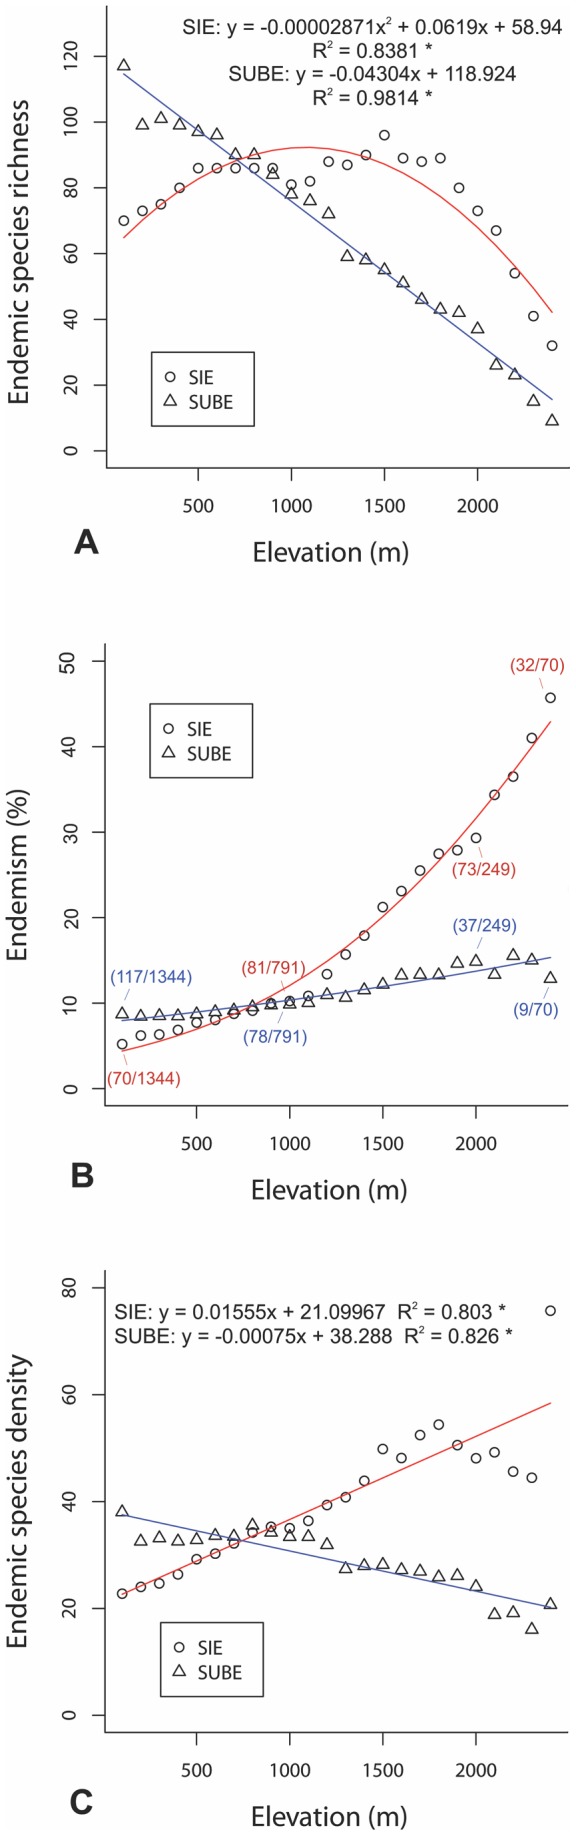
Elevational gradient of vascular plant endemism in Crete.Elevational gradient of (A) endemic species richness, (B) percentage of endemic species (with species numbers provided for 100, 1000, 2000 and 2400 m elevational intervals) and (C) endemic species density, for Single Island Endemics (circles) and Subendemics (triangles). Trend lines were set by simple regressions (A, C) and generalized linear models (B). (* p<0.001).